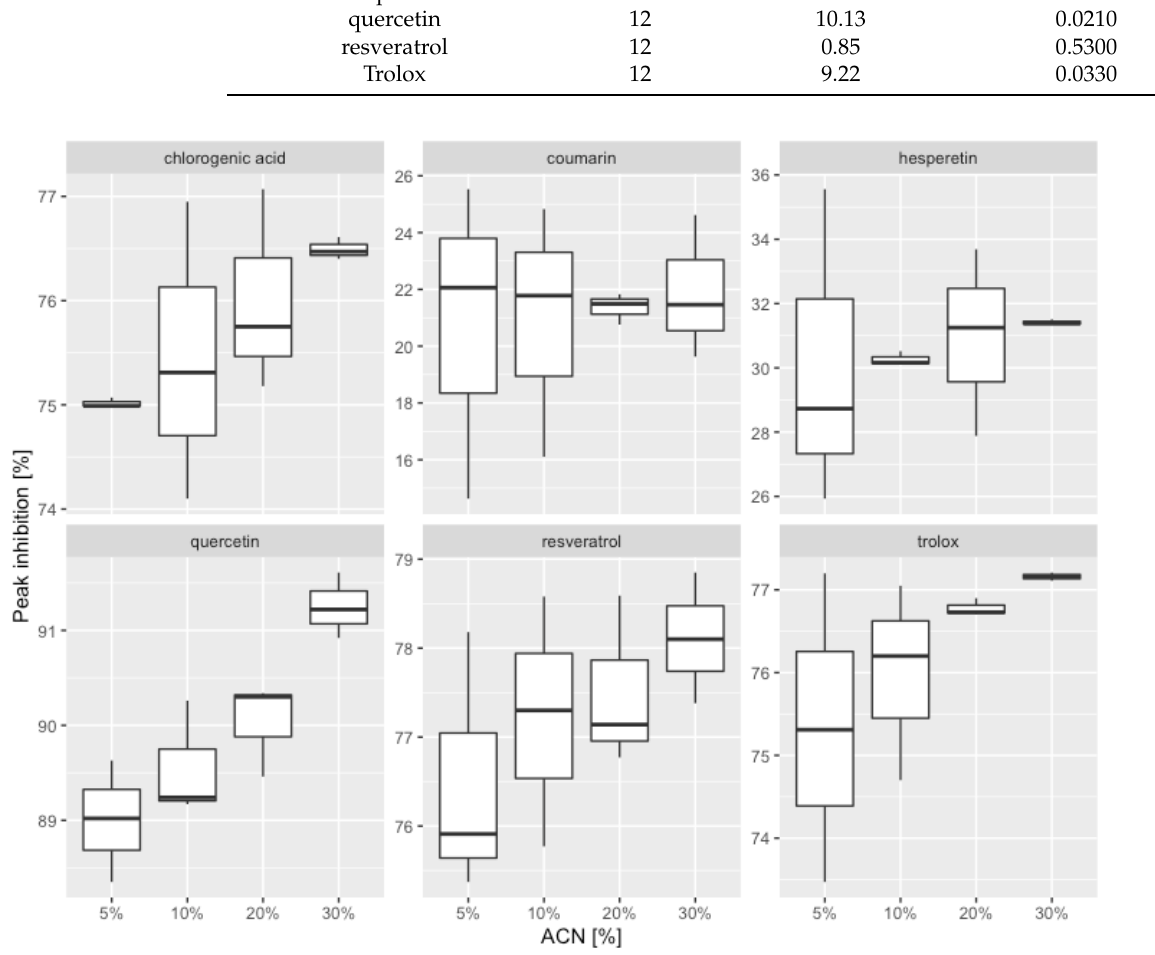
Figure 7. Box plots of peak inhibition within different gradient profiles.